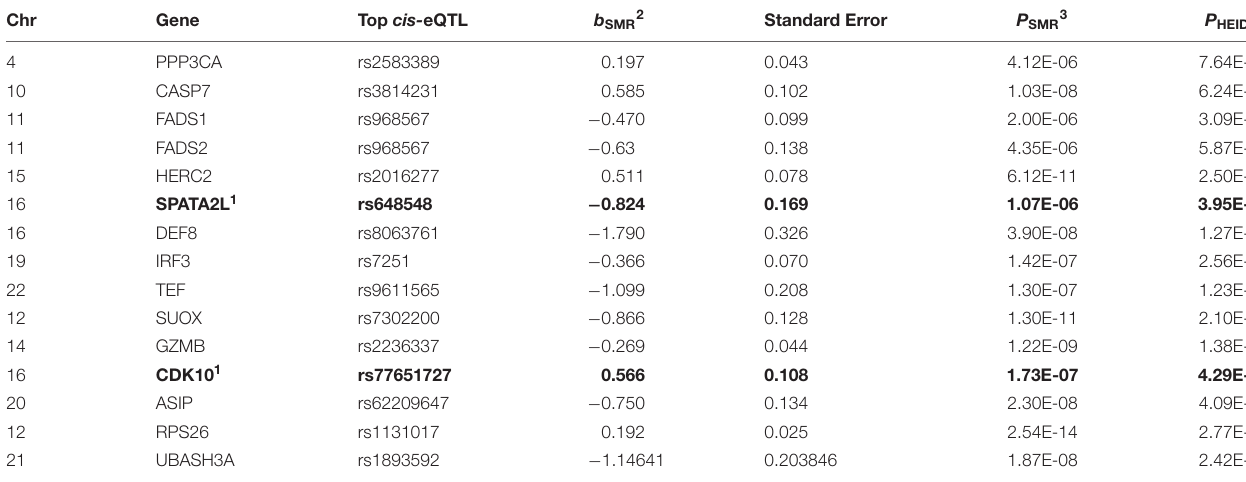
TABLE 2 | Identification of 15 genes by the SMR and HEIDI analysis for vitiligo